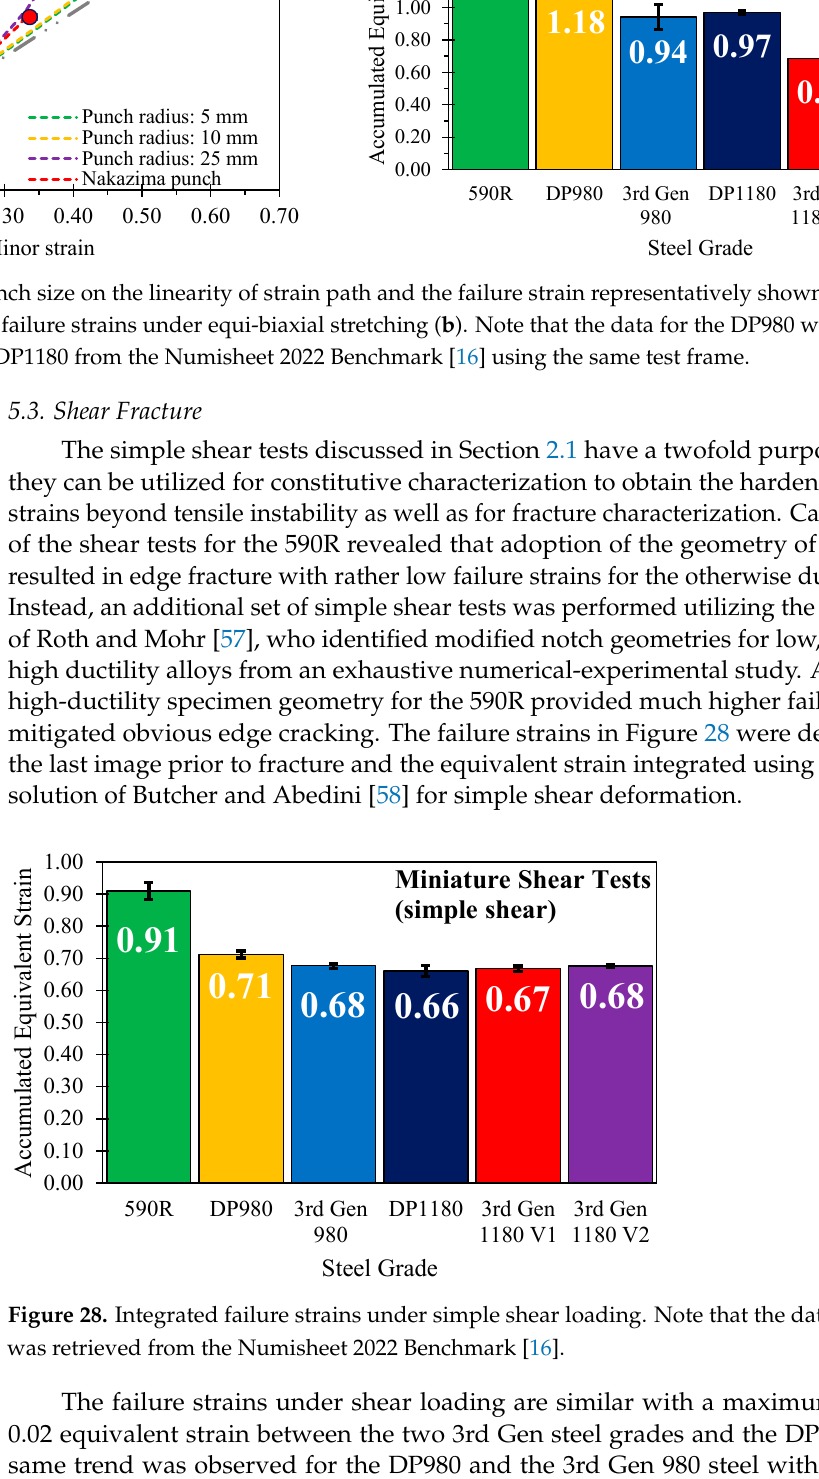
27 of 39 Figure 26. Failure bend angles ( a ) and equivalent strains ( b ) under plane strain tension. Note that the data for the plane strain fracture strain of the same lot of the DP1180 was reported in Noder et al. [13] for a von Mises material and was integrated using the Barlat Yld2000 plasticity model as part of this study. 5.2. Miniature Dome—Equi-Biaxial Fracture Miniature dome tests using a 5 mm punch radius were conducted utilizing the MTS formability press adopted for the formability characterization. The Marciniak die set was replaced with a miniature set-up depicted in Figure 25b and 120 grit Emery cloth was taped to the die and binder faces to prevent material draw-in during testing. Specimens were sheared to square blanks of 203 mm by 203 mm and deformed at a punch speed of 0.25 mm/s and a clamping load of 640 kN. Teflon film was adopted to promote failure without necking at the dome apex as illustrated for the 3rd Gen 980 in Figure 27a. Adop- tion of smaller punch radii induces a more severe stress-strain gradient through the sheet thickness that delays and/or suppresses tensile instabilities and thus provides higher fail- ure strains under approximately proportional loading conditions [54]. Since failure is ini- tiated on the convex surface of the test specimen, the failure strains could directly be ex- tracted with a circular, 0.5 mm diameter, inspector tool in the software Vic3D ® of Corre-